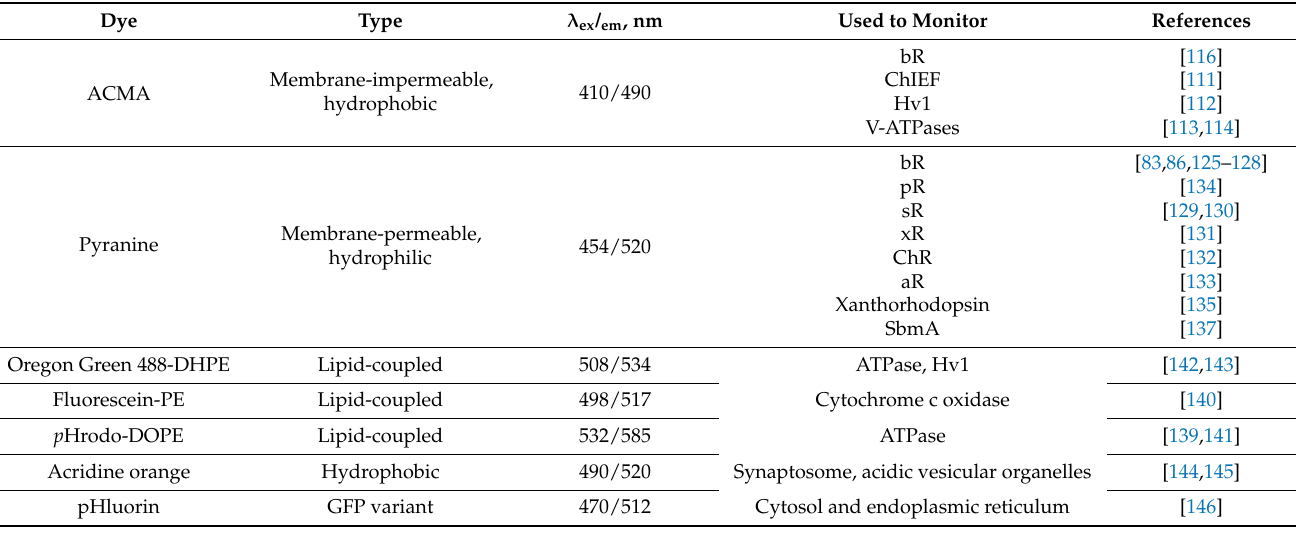
Table 1. List of p H-sensitive dyes commonly used to monitor proton pumping